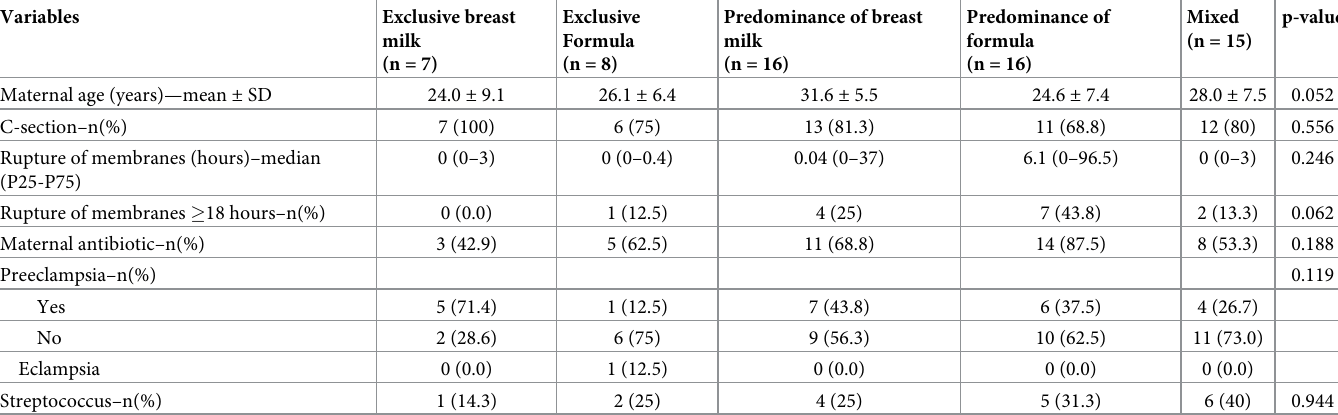
Table 1. Characteristics of the subjects.